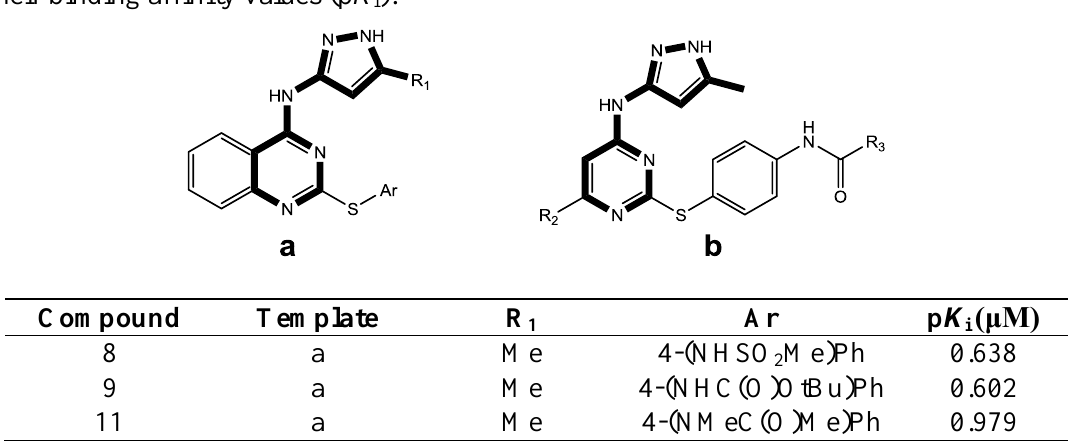
Table 1. Representative skeletons and molecular structures of MK-0457 derivatives and their binding affinity values (p K i